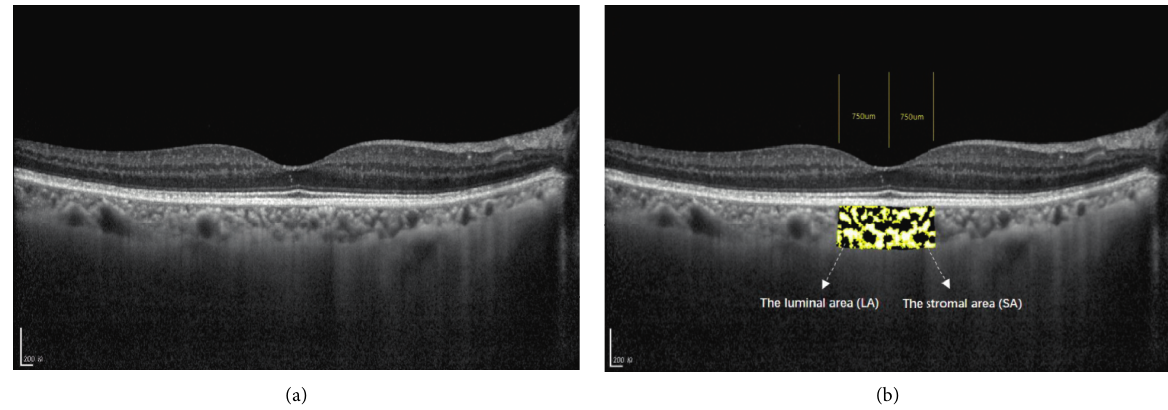
Figure 1: Representative images of processing to obtain the choroidal vascularity index using EDI-OCTscans. (a) Original OCTimage. (b) Overlay image of an EDI-OCTscan with the region of interest obtained after image binarization. EDI-OCT: enhanced depth imaging-optical coherence tomography; DN: diabetic nephropathy; DR: diabetic retinopathy; PDR: proliferative diabetic